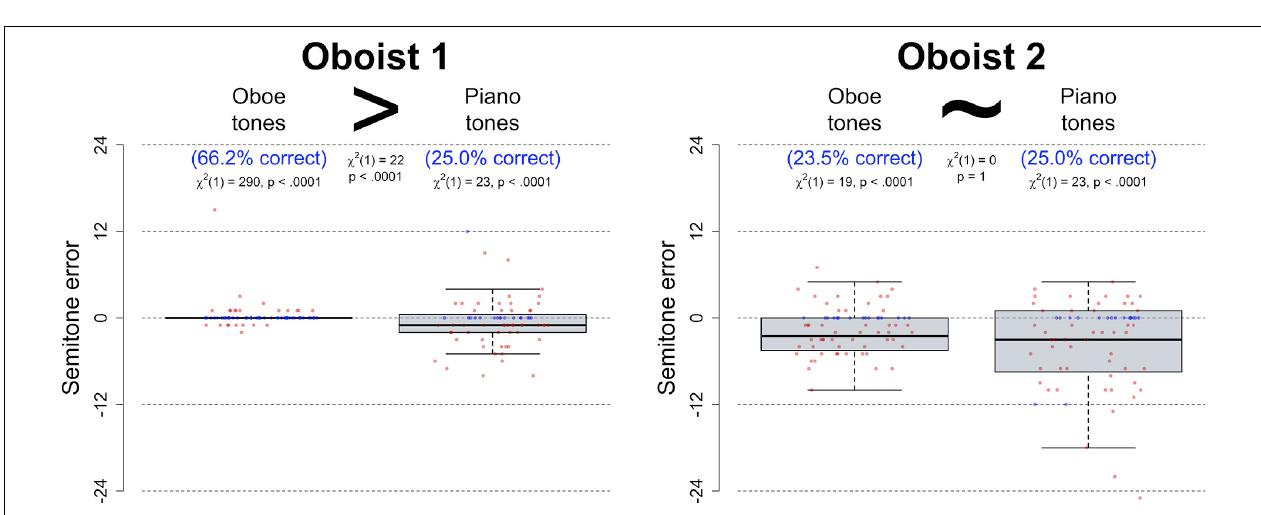
FIGURE 3 | Boxplots with raw data of response deviation (in semitones) from the target pitch for correct (blue) and incorrect (red) pitch identification responses provided by the two oboists during Experiment A. Responses pertain to oboe tones (left) and piano tones (right), the former of which were recorded by the relevant oboist herself on her own instrument. Percentage of correct responses in each condition is indicated in blue writing, and the box plots depict the number of semitones that responses were off from the target. The presence and direction of significant differences between conditions—as assessed with Pearson’s chi-squared tests—are indicated with “ > ” signs whereas “ ∼ ” indicates that there was no significant difference between conditions. Whereas both oboists performed above chance for both oboe and piano tones, Oboist 1 furthermore identified pitch more accurately and made errors that were closer to the correct response for oboe compared to piano